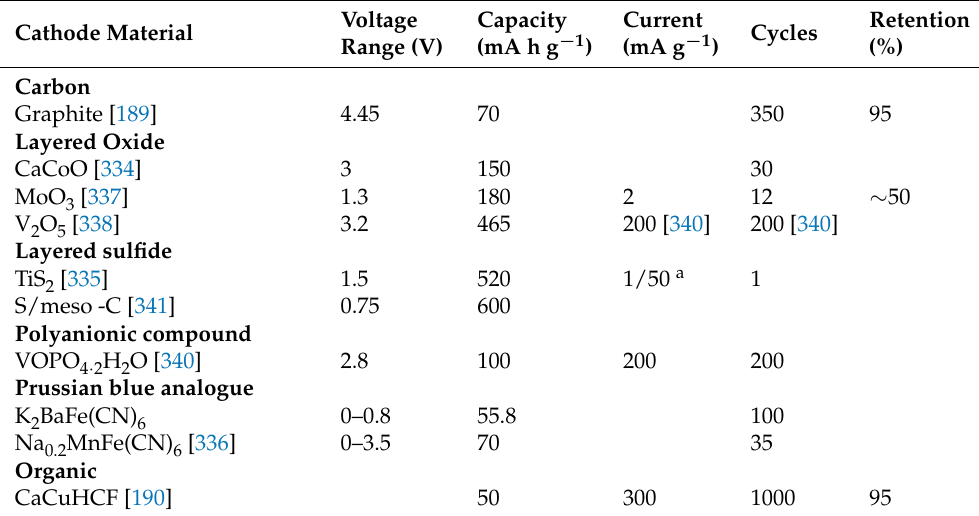
Table 12. Cathode materials for Ca-based